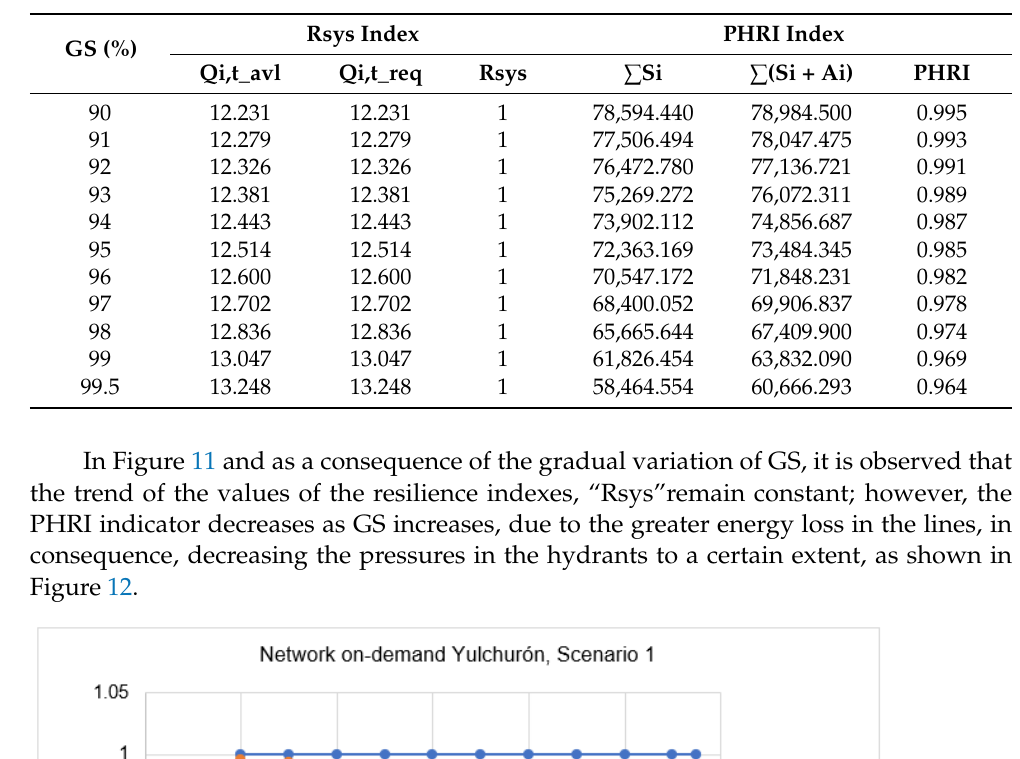
Table 4. “Rsys” and “PHRI” results, in scenario 1 on-demand.